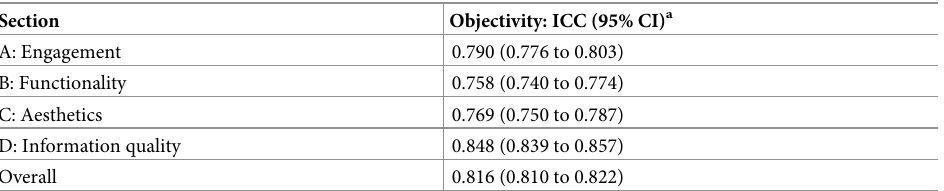
Table 4. Objectivity of the